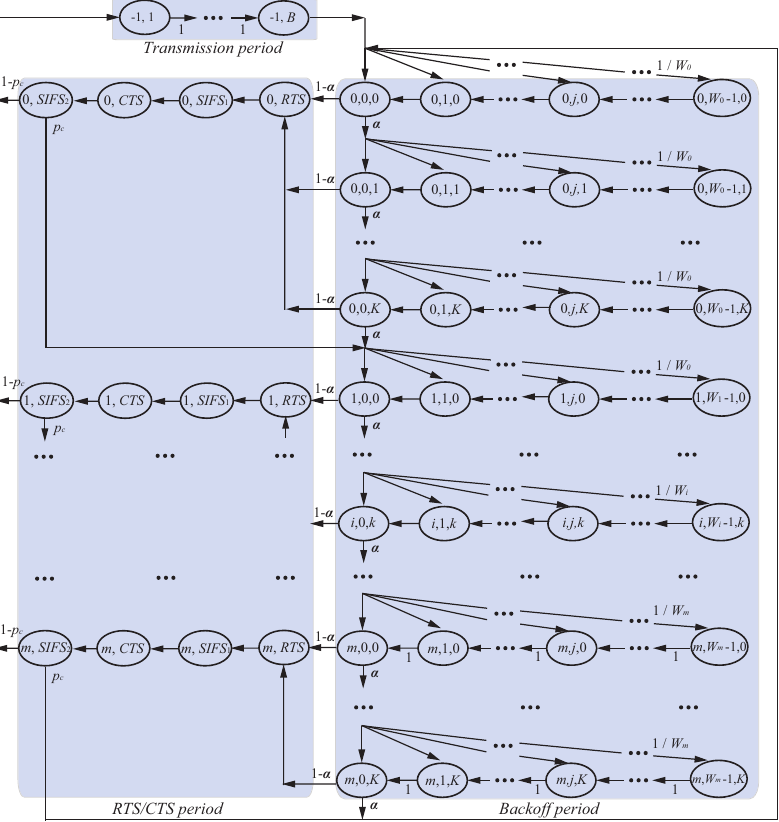
Figure 7. Markov–chain model for the improved backoff scheme.